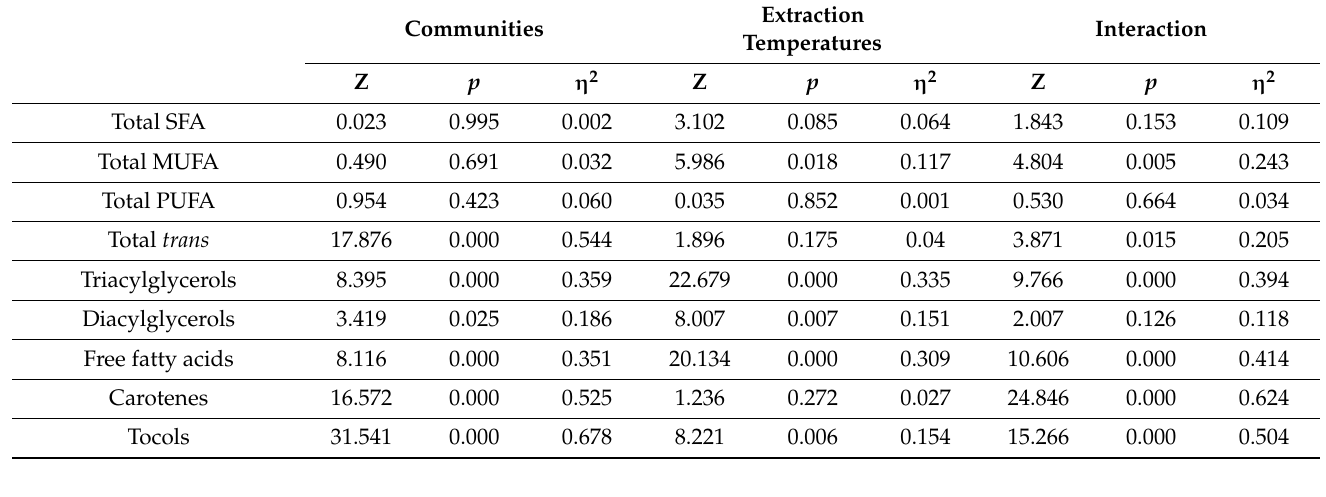
Table 3. Multivariate analysis of variance applied to lipid main classes.